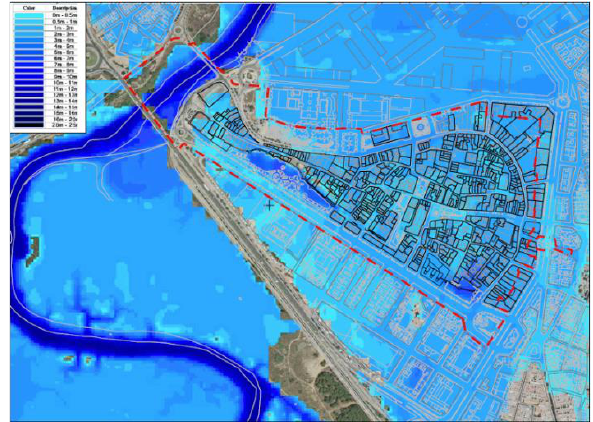
Figure 7. Draught levels. Return period of 500 years.